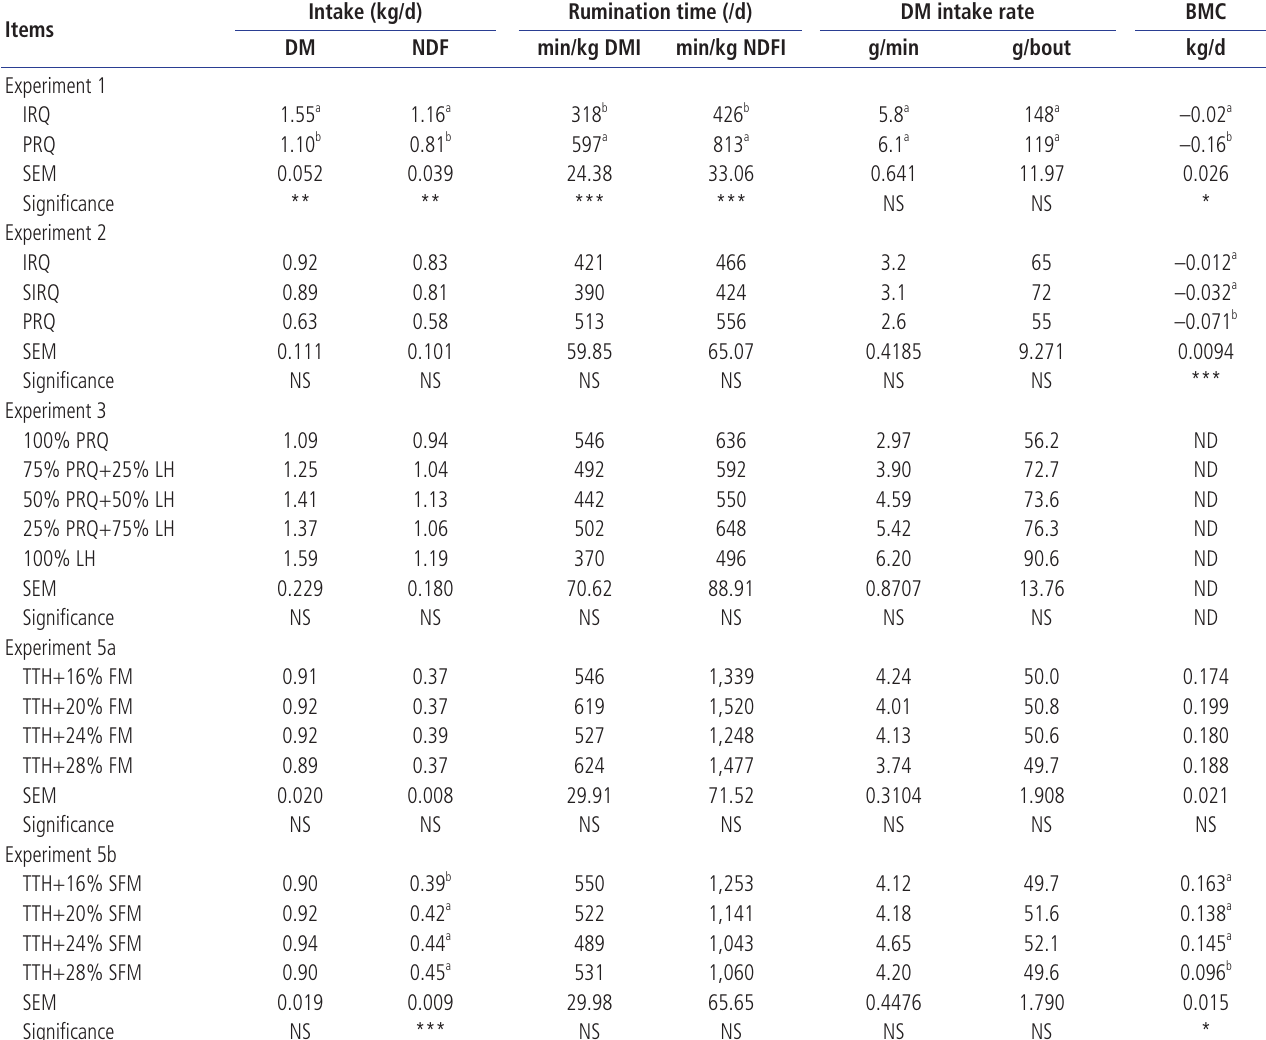
Table 3. Effect of improving veld hay quality on diurnal feeding behaviour in Merino sheep (Exp 1, 3, 5) and Nguni goats (Exp 2)